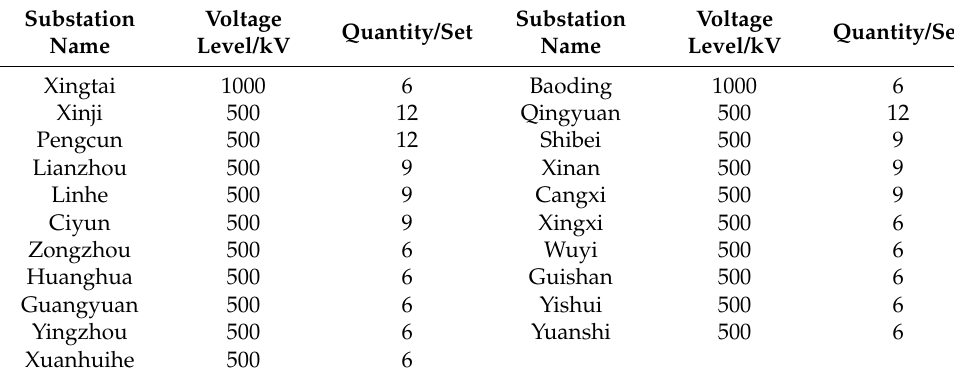
Table 3. Substation of transformer in sample library.